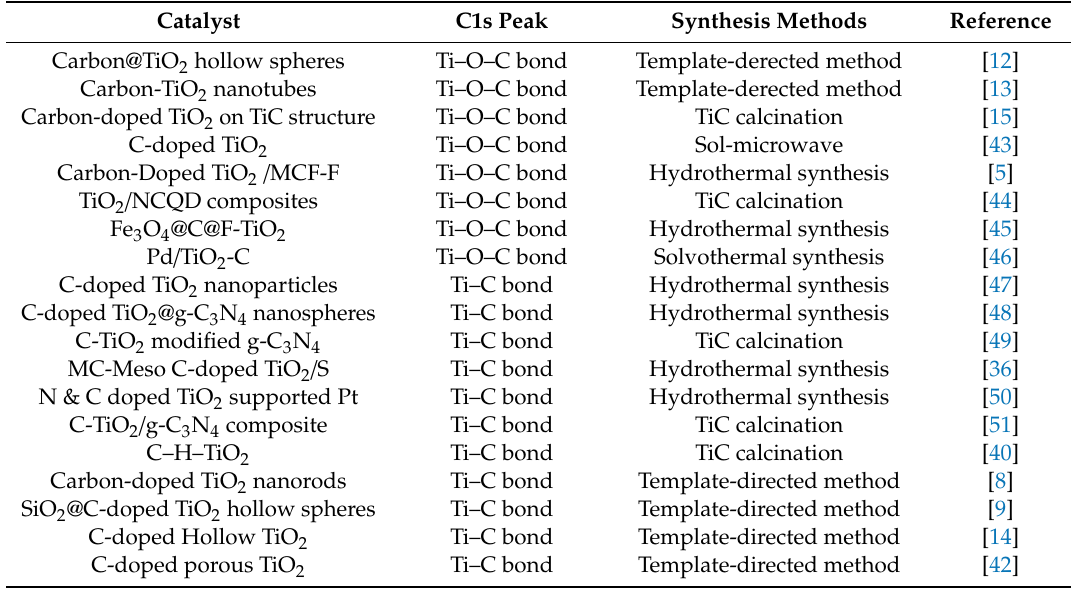
Table 1. The C1s peak and typical synthetic method of C-doped TiO 2